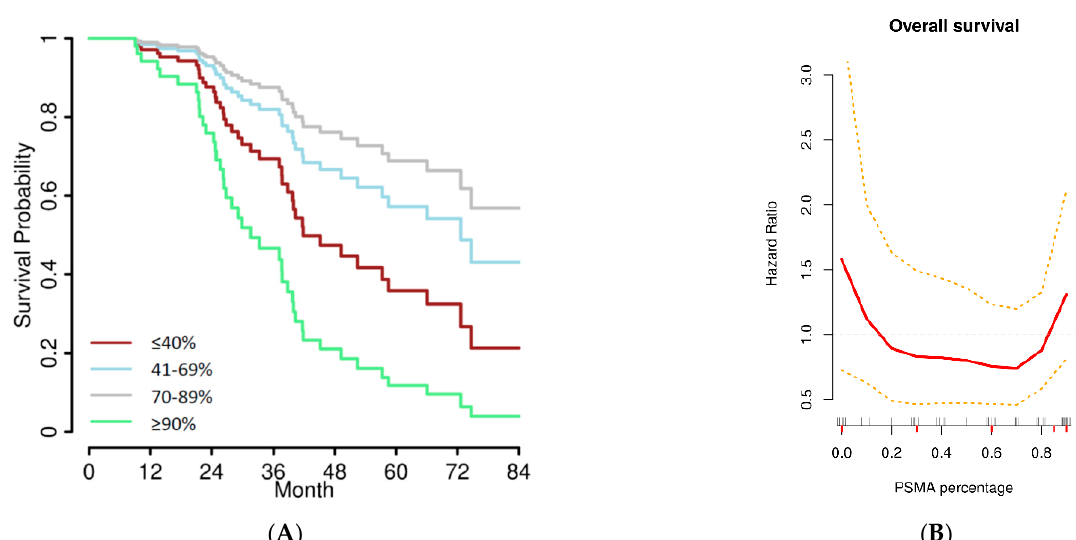
Figure 2. ( A ) Overall survival stratified by quartiles of PSMA expression in a multivariate model considering age, FIGO stage, and residual tumor. Using a univariate Cox regression, the distribution of median overall survival for the four groups was as follows: 66.1 months (70–89%), 57.3 months (41–69%), 39.9 months ( ≤ 40%), and 38.8 months ( ≥ 90%). As these survival curves in (A) represent a multiple Cox regression model, no censored patients are indicated. ( B ) Hazard ratio for overall survival significantly increased in cases with low ( ≤ 10%) and high ( ≥ 90%) PSMA expression (crossing the red HR curve with the HR = 1 line in grey); thus, they were combined for further analyses (“low/high” PSMA group, n = 34) and compared to cases exhibiting PSMA expression between 20% and 80% (“medium” PSMA group, n = 46). Small bars at the top of the x -axis indicate single samples (jittered), and red bars at the bottom of the x -axis are the minimum, the 25th, the 50th, and the 75th percentiles, and the maximum of PSMA expression, the so-called five-number